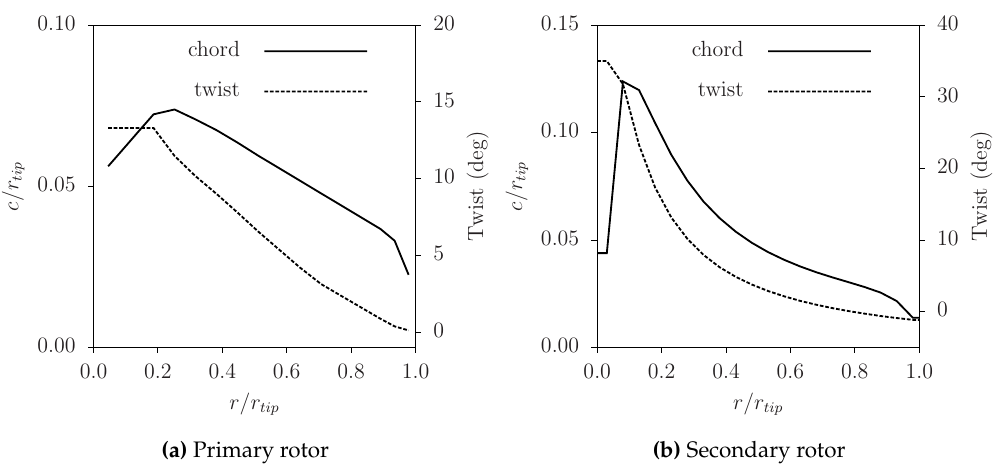
Figure 5. Radial distributions of the ( a ) primary and ( b ) secondary rotor blade chord and twist of the dual-rotor wind turbine (DRWT) configuration analyzed